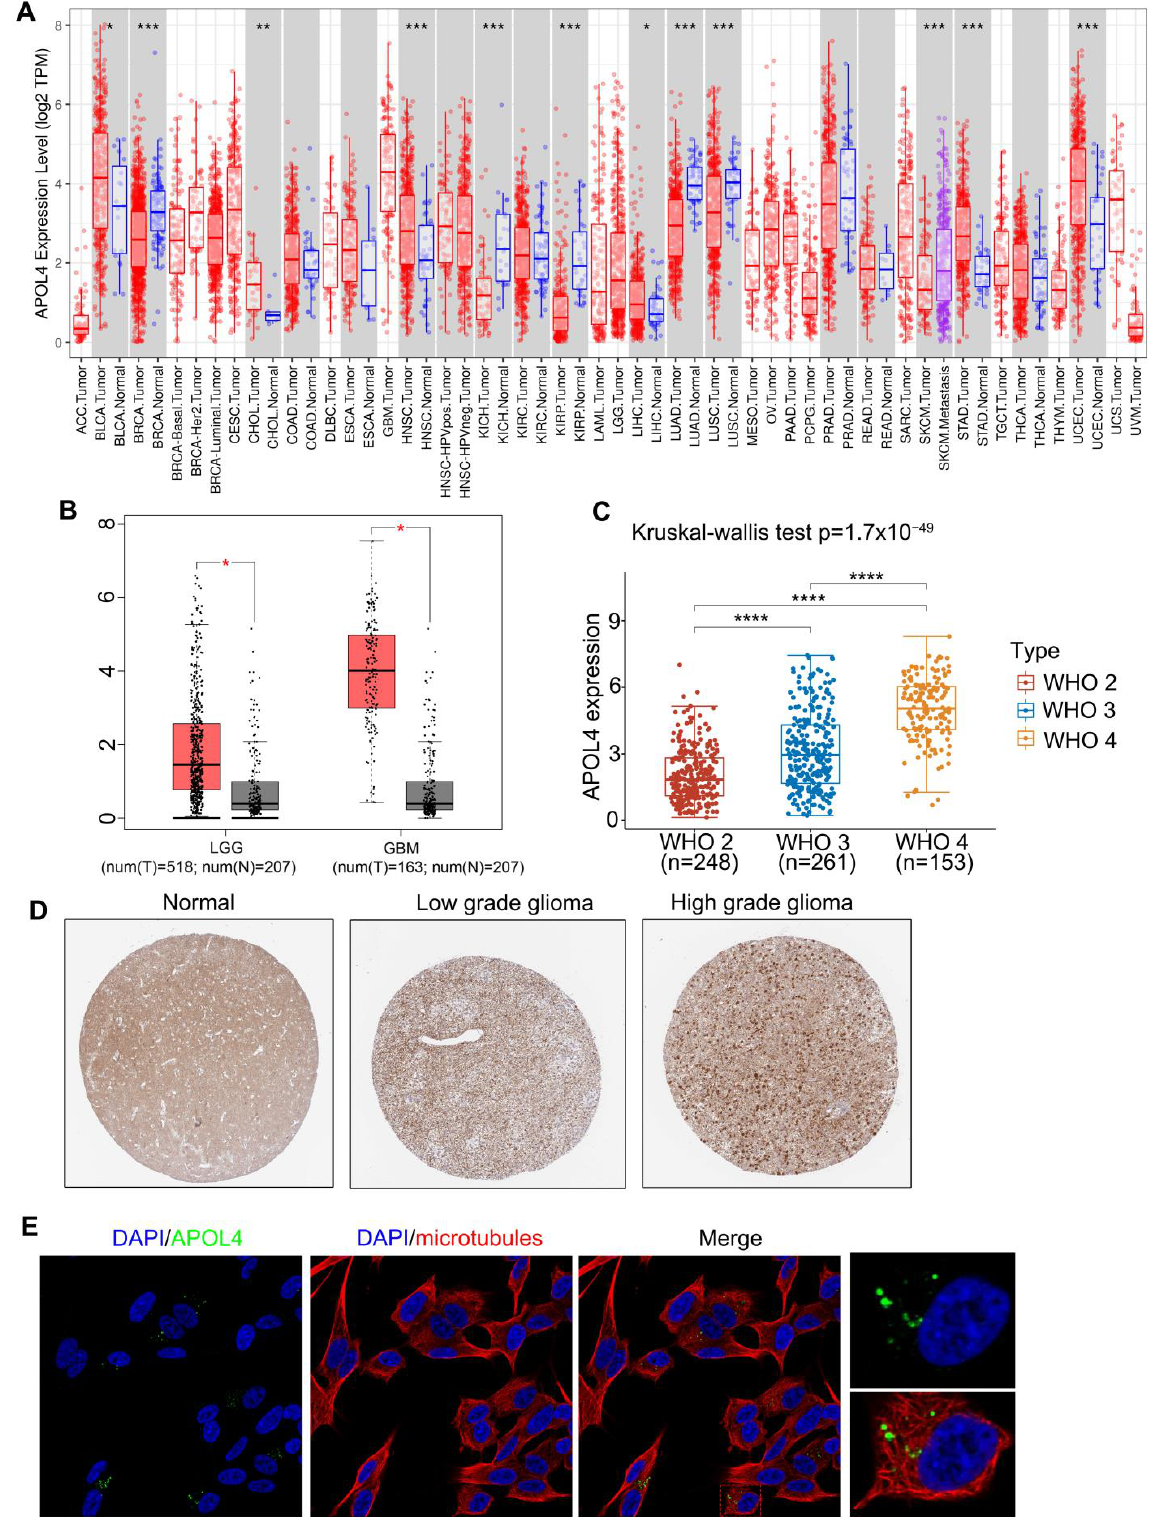
Figure 1. The expression of APOL4 in gliomas and other cancers. ( A ) The APOL4 expression in human tumors. ( B ) The APOL4 expression in LGG, GBM, and normal tissues. ( C ) The APOL4 expression in different WHO grades in gliomas. ( D ) The IHC staining of APOL4. ( E ) The immunofluorescence of APOL4 in the SH-SY5Y cell line. * p < 0.05, ** p < 0.01, *** p < 0.001, and **** p <